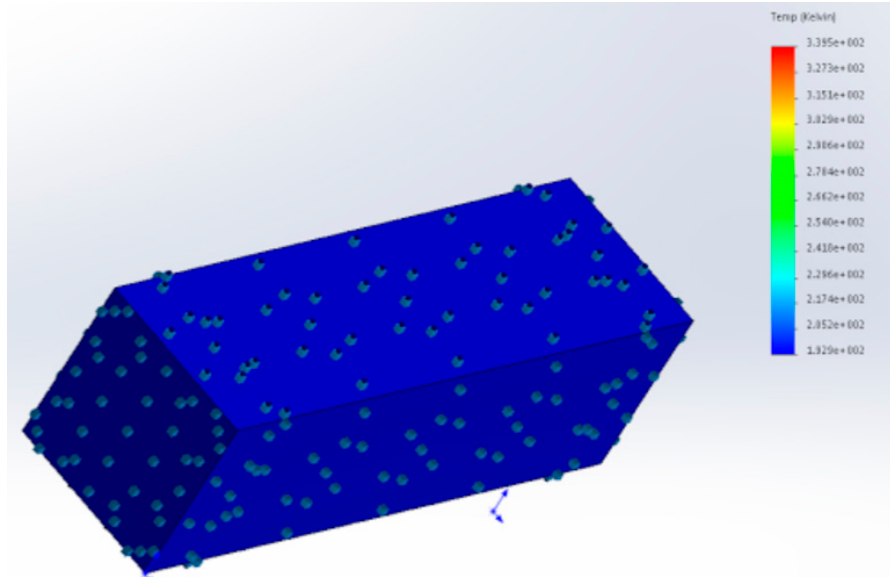
Figure 59. Cold case power dissipation simulation.